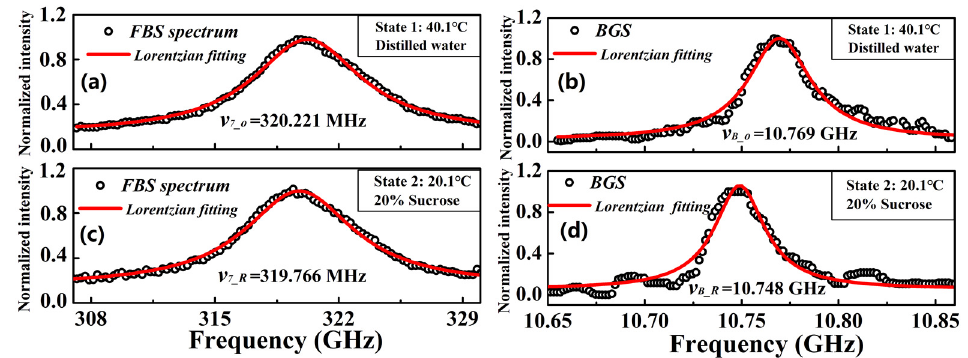
Figure 10. The measured induced FBSS induced by radial acoustic mode of ( a ) R 0,7 at State 1 and ( c ) R 0,7 at State 2 as well as BGS at ( b ) State 1 and ( d ) State 2. By regarding State 1 as the original state and solving Equations (10) and (11), the temperature and acoustic impedance at State 2 can be obtained as T R _ e = 19.9 ◦ C and Z R _ e = 1.670 kg/(s · mm 2 ), respectively. Therefore, the experimental measurement uncer- tainties of temperature ( δ T e = | T R _ e − T R |) and acoustic impedance ( δ Z e = | Z R _ e − Z R